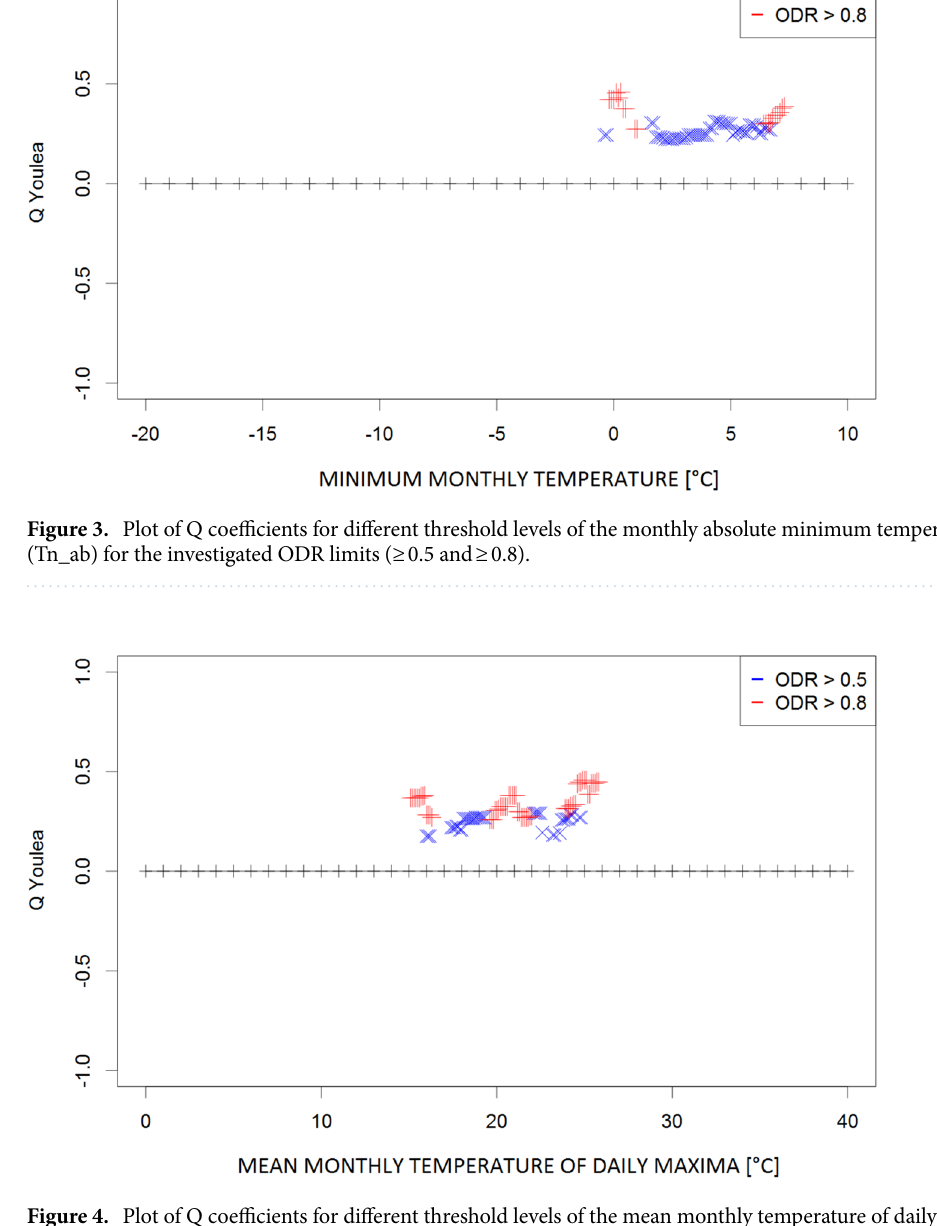
Figure 4. Plot of Q coefficients for different threshold levels of the mean monthly temperature of daily maxima (Tx) for the investigated ODR limits (≥ 0.5 and ≥